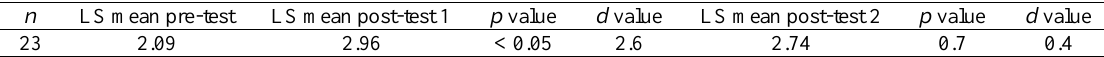
Table 3 ANOVA for problem recognition of experimental